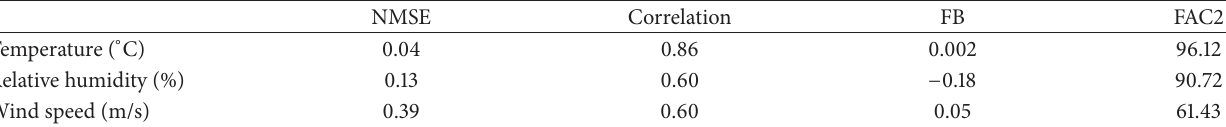
Table 2: Statistical analysis of WRF